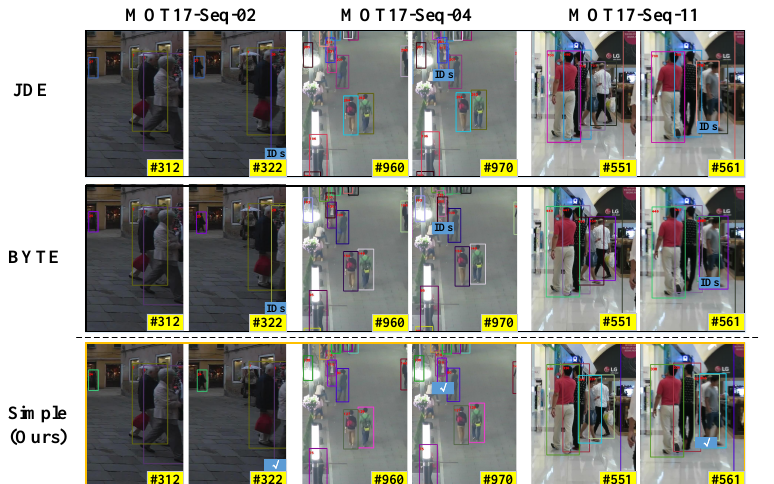
Figure 6. Robustness of our tracking strategy compared to BYTE and JDE-based methods. Boxes with the same color indicate that the tracking targets have the same identity; IDs indicates that the tracking targets have switched their identities. The check mark indicates that the identity of the target has not changed. The #number indicates that the frame number in mot17 video sequence.